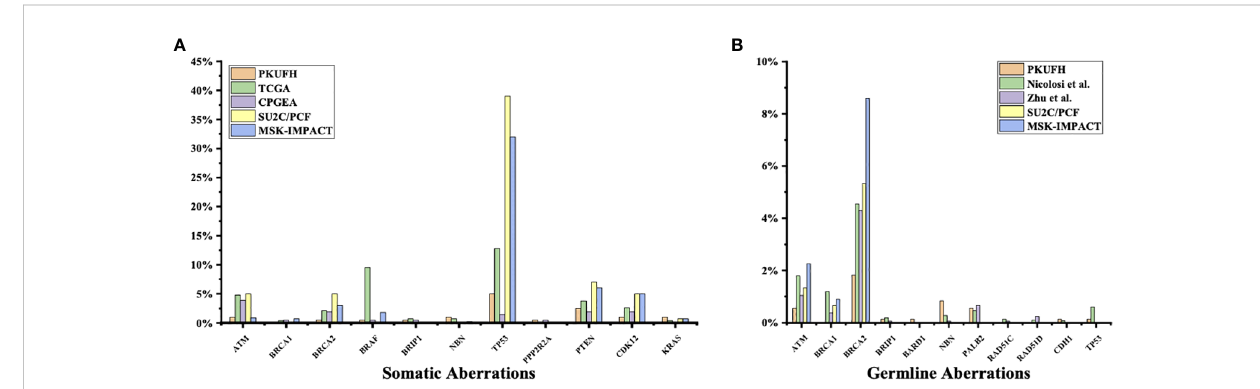
FIGURE 2 Comparison of somatic and germline variants between this study and previous ones (A) Somatic pathogenic variants in our study (Peking University First Hospital, PKUFH), PRAD from TCGA, Chinese Prostate Cancer Genome and Epigenome Atlas (CPGEA), SU2C/PCF, and MSK-IMPACT. CPGEA is a cohort with 208 pairs of tumor tissue samples and matched healthy control tissue from Chinese patients with primary prostate cancer. TCGA, SU2C/PCF, and MSK-IMPACT focused mostly on Caucasian populations. SU2C/PCF pro fi led only patients with metastatic castration resistant prostate cancer. (B) Germline Pathogenic variants (PV) and likely pathogenic variants (LPV) in PKUFH, studies by Nicolosi et al. and Zhu et al., SU2C/ PCF, and MSK-IMPACT. The study by Nicolosi et al. recruited mostly patients with Caucasian descendance. The study by Zhu et al. recruited Chinese patients, mostly with metastatic